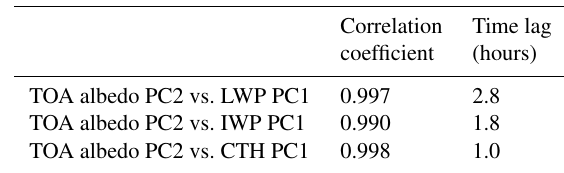
Table 2. Same as Table 1, but for modelled top-of-atmosphere (TOA)